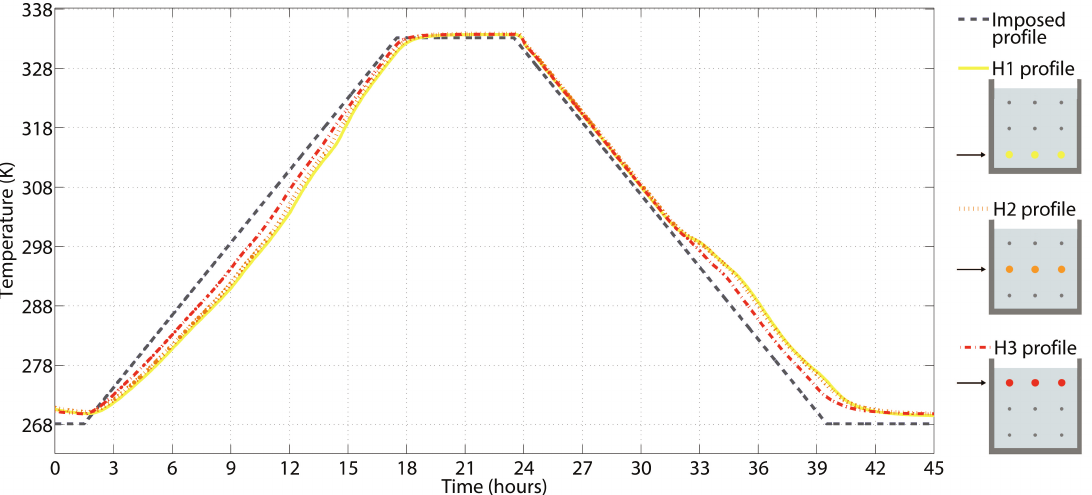
Figure 7. Animal fat average thermal profiles at the three considered